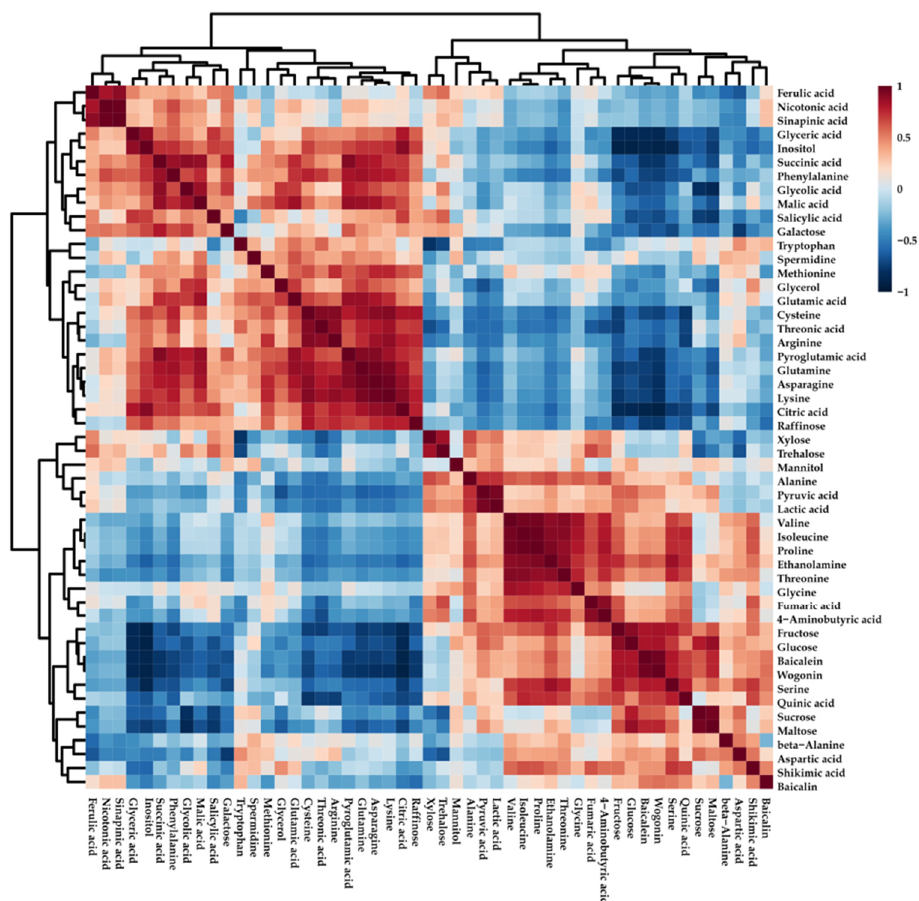
Figure 3. Correlation matrix of metabolites in the roots of S . baicalensis plantlets treated with chilling.